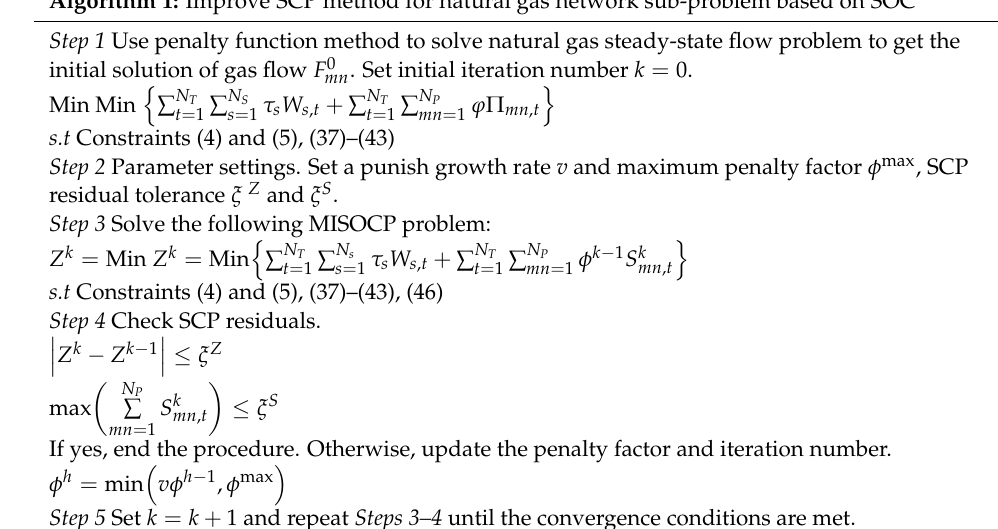
Algorithm 1: Improve SCP method for natural gas network sub-problem based on SOC